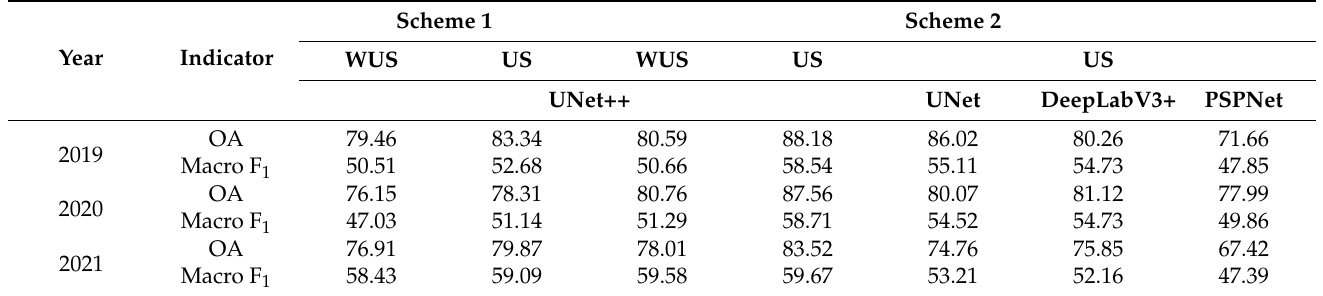
Table 4. Training parameter results from different schemes and models. Without upsampling and upsampling are abbreviated as WUS and US,